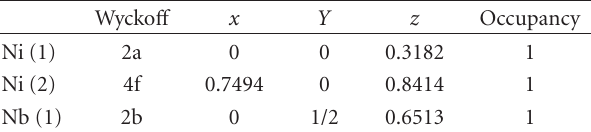
Table 2: Structural parameters for δ phase at 25 ◦ C: Pmmn (no.